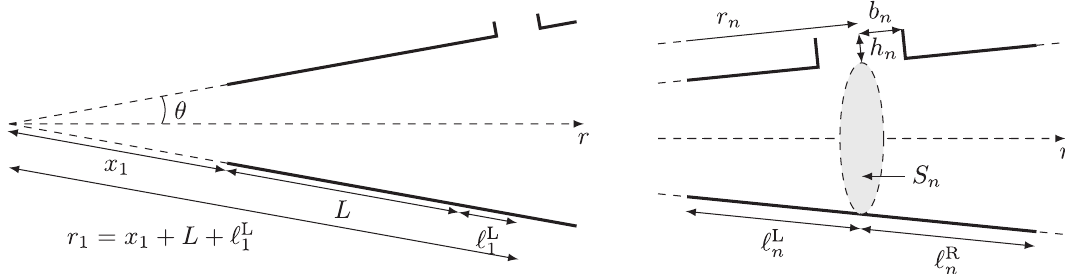
and chimney height h n . The cross-section of the n